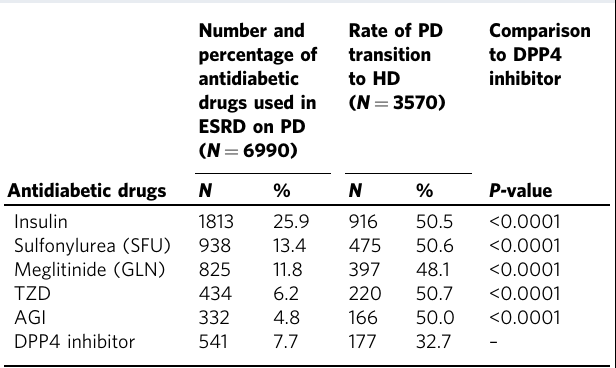
Table 3 Rate of PD transition to HD among subgroups of antidiabetic drugs.